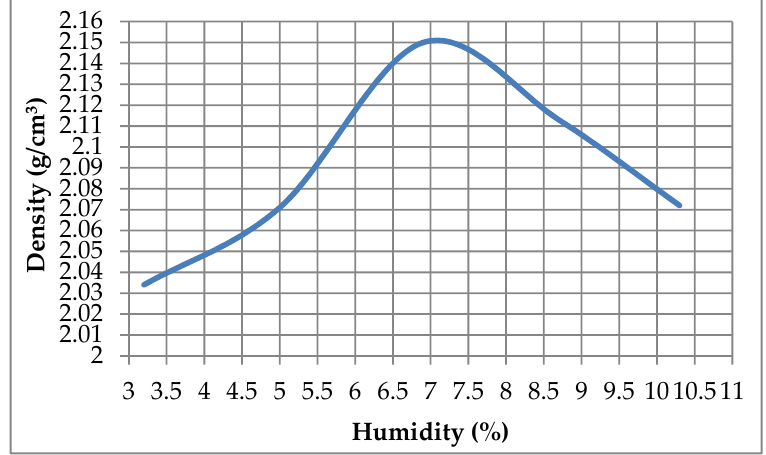
Figure 7. Modified proctor.